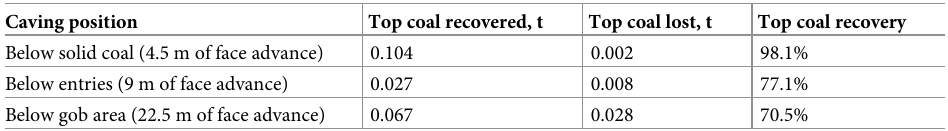
Table 2. Top coal recovery at different caving positions. Caving position Top coal recovered, t Top coal lost, t Top coal recovery Below solid coal (4.5 m of face